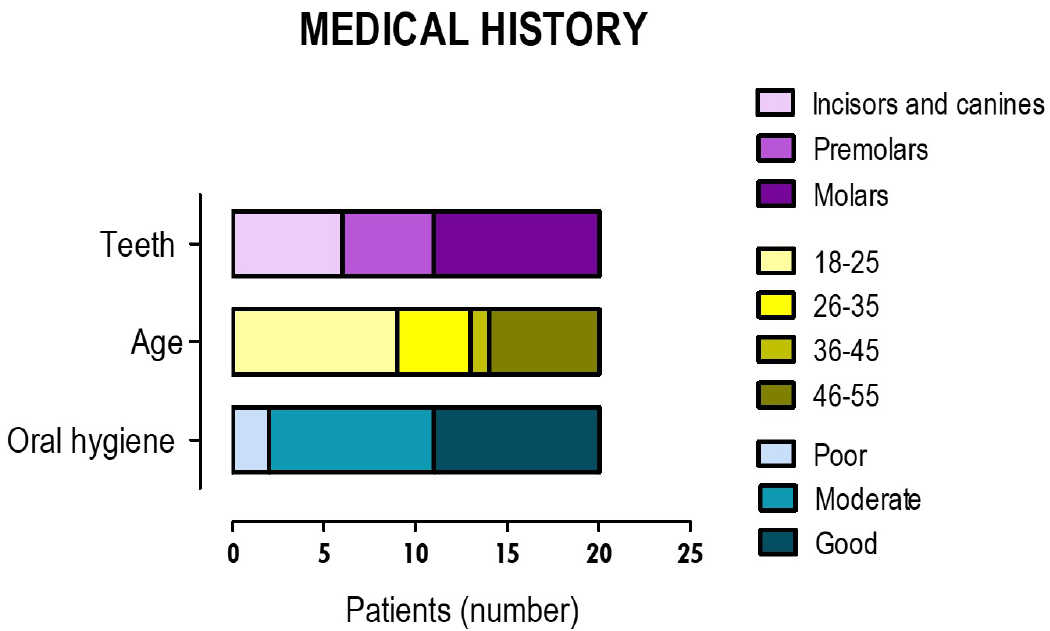
Figure 1. Relevant aspects of the clinical history of patients who were included in the clinical study, namely age, hygiene habits, and type of teeth intervened. Results corresponded to 20 patients in whom pulp capping therapies were performed on 21